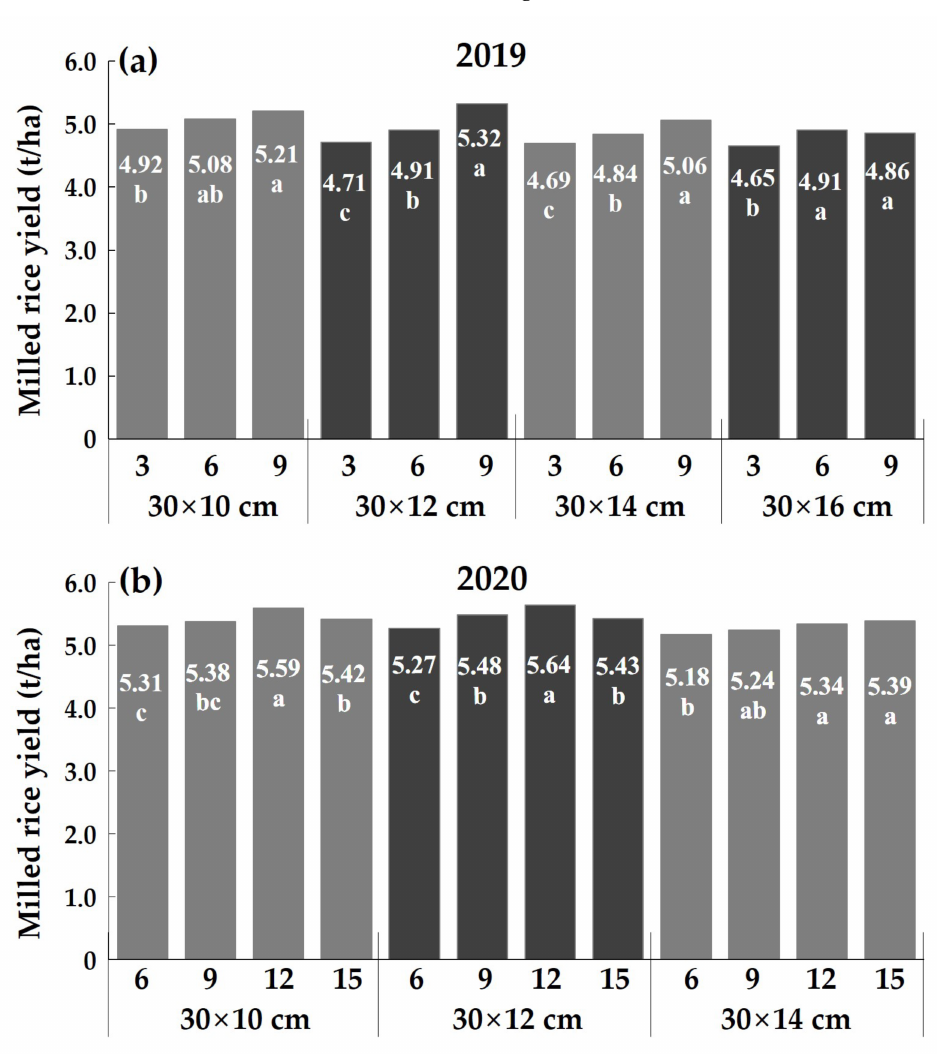
Figure 3. Milled rice yield according to the transplanting density (transplanting distance, seedling number): ( a ) milled rice yield of 2019: the transplanting distance of 4 treatments (30 × 10 cm, 30 × 12 cm, 30 × 14 cm, and 30 × 16 cm) and the seedling number of 3 treatments (3, 6, and 9); ( b ) milled rice yield of 2020: the transplanting distance of 3 treatments (30 × 10 cm, 30 × 12 cm, and 30 × 14 cm) and the seedling number of 4 treatments (6, 9, 12, and 15). Each data point is the mean of the replicates. Means with the same letters in the transplanting distance are not significantly different at the 5% level, as determined by Duncan’s multiple range